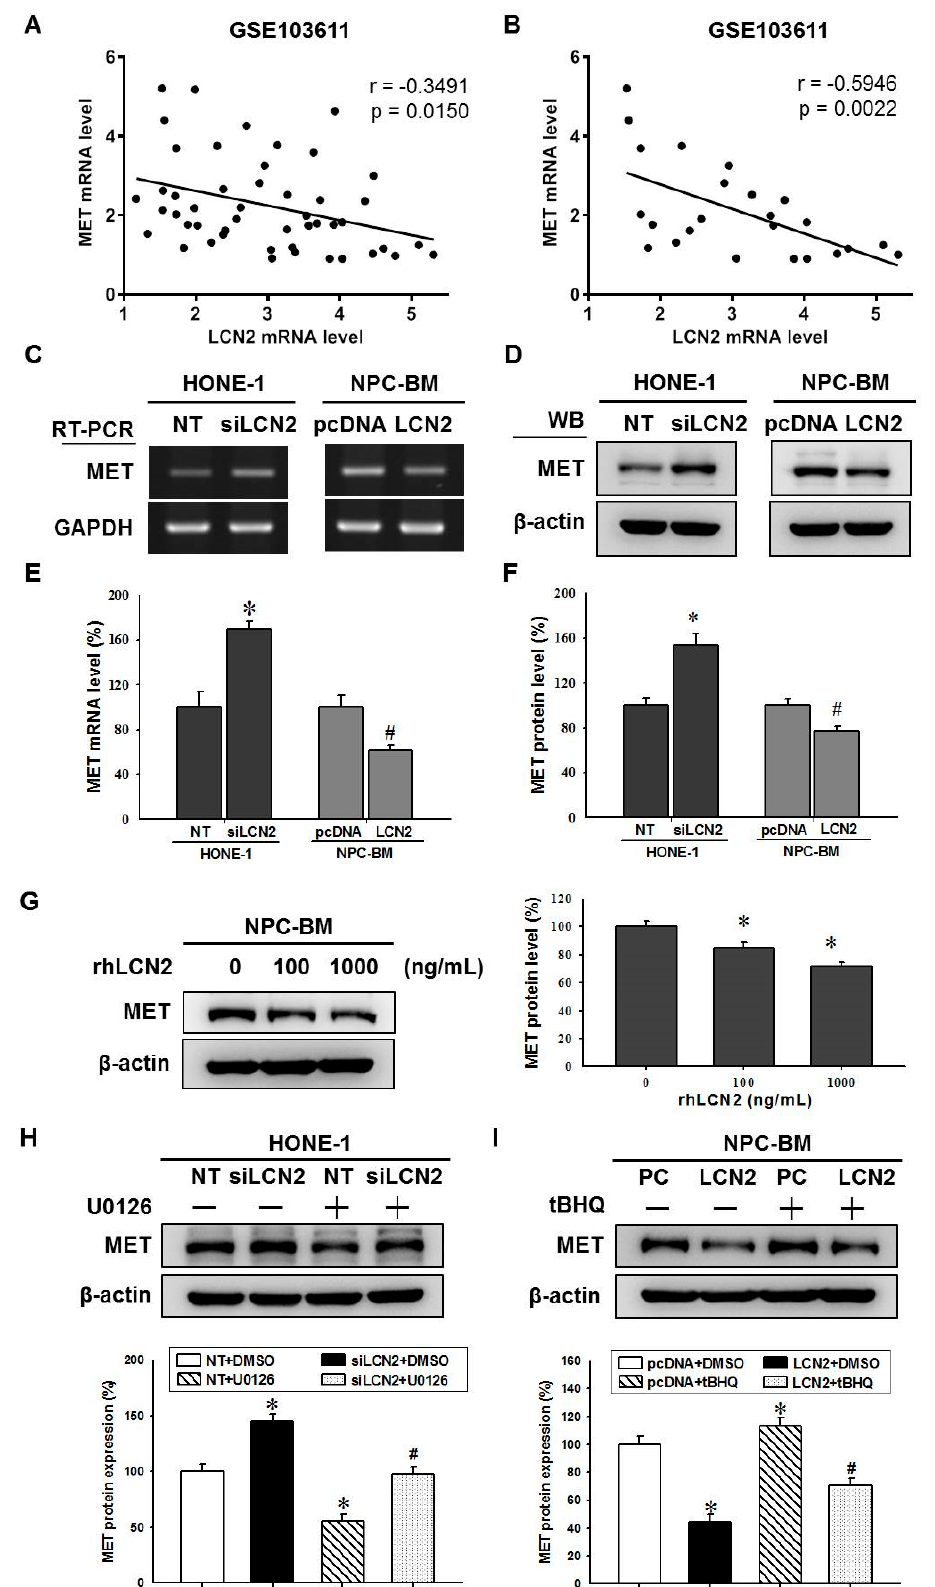
Figure 4. LCN2 down-regulated MET levels through the MEK/ERK cascade in human NPC cells. ( A ) The Pearson correlation between LCN2 and MET mRNA levels in samples from metastatic and non-metastatic NPC patients ( n = 48) were examined based on GSE103611. ( B ) The Pearson corre- lation between LCN2 and MET mRNA levels in samples from metastatic NPC patients ( n = 24) were examined based on GSE103611. ( C , D ) The HONE-1 cells were transfected with siRNA against LCN2 (siLCN2) or control (NT) (left panel). The NPC-BM cells were transfected with control plasmids (pcDNA) or plasmids containing LCN2 (LCN2) (right panel). MET mRNA and protein levels were determined using RT-PCR and Western blot (WB) analysis. ( E ) MET mRNA level after transfection as ( C ) was using real-time qPCR analysis. ( F ) Quantitative analysis of MET protein levels in ( D ). ( G ) NPC-BM cells were treated with recombinant human LCN2 (rhLCN2, 0–1000 ng/mL) and then examined in terms of MET protein levels. * p < 0.05 when compared with control. ( H ) The HONE-1 cells that were transfected with siLCN2 or NT and then treated with the MEK/ERK inhibitor, U0126. Then, MET protein levels in these cells were examined by Western blot analysis. ( I ) The NPC-BM cells that were transfected with pcDNA or LCN2 plasmids and then treated with the ERK activator, tBHQ. MET protein levels in these cells were examined by Western blot analysis. * p < 0.05 compared with control. # p < 0.05 when compared with HONE-1 cells that were transfected with NT plus U0126 or NPC-BM cells that were transfected with pcDNA plus tBHQ. 3.5. LCN2 Decreased Cell Migration by Reduced MET Expression The level of MET in NPC tissues is directly and positively correlated with the clini- cal stage of NPC patients [27]. The downregulation of MET levels efficiently suppresses invasion and migration of NPC cells [28,29]. Thus, we further examined whether LCN2 negatively regulates cell migration by repressing MET levels. The MET protein was overexpressed in the NPC-BM cells (Figure 5A). As expected, the overexpressed MET levels could enhance cell migration in the NPC-BM cells (Figure 5B) similarly to previ- ous studies. Conversely, the HONE-1 cells with reduced MET levels by a specific siR- NA-targeting MET (siMET) exhibited a down-regulation of cell migration (Figure 5C,D). It is worth noting that the reduced MET levels also decreased siLCN2-induced cell mi- gration (Figure 5C,D). The data suggested that LCN2 negatively regulated NPC cell mi- gration by reducing MET levels.